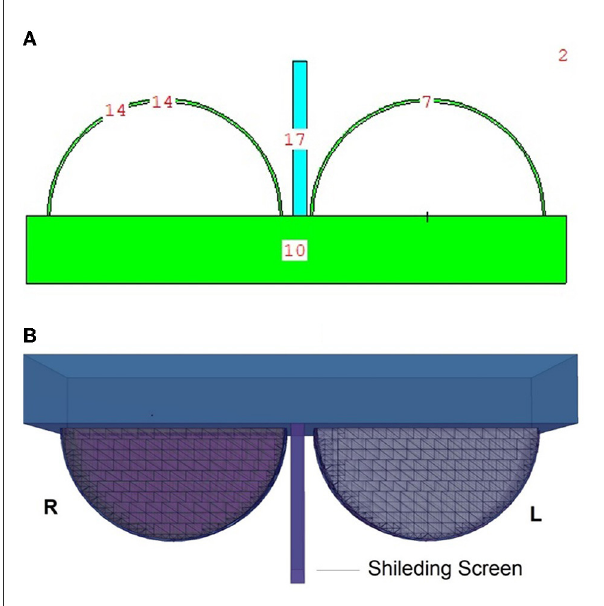
FIGURE4 (A, B) Depict the 2D and 3D top views of the shielding screen positioned in the geometric center of the breast phantom model,